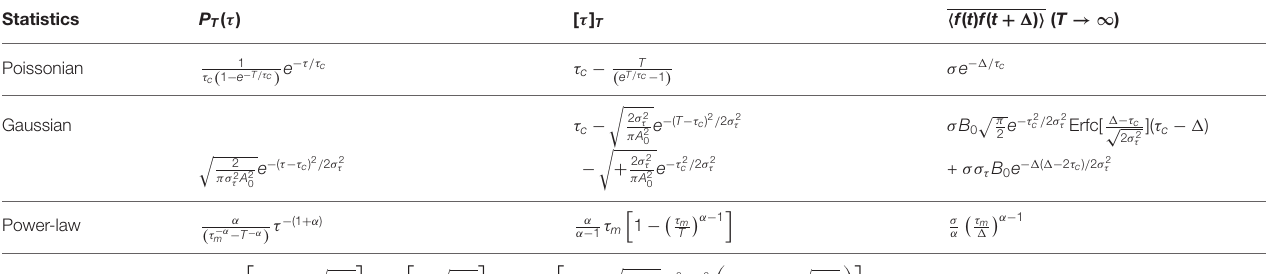
TABLE 1 | The three duration time PDFs considered in our telegraphic noise f ( t ) and their statistical properties.